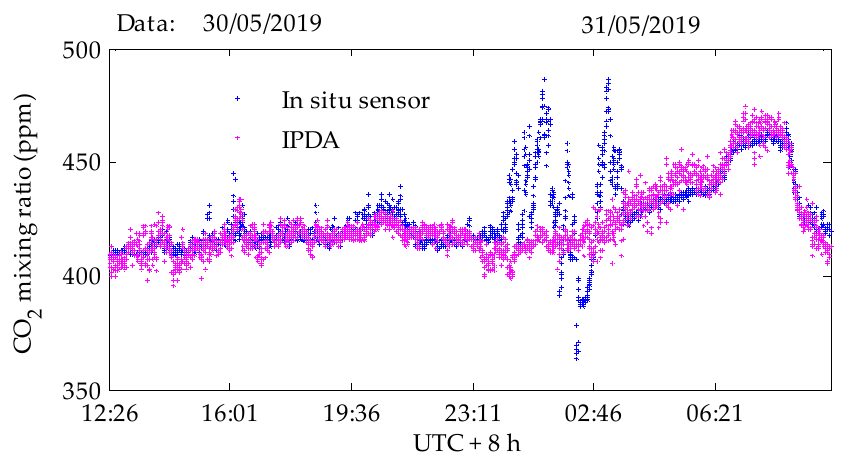
Figure 17. Simultaneous measurements of the diurnal variations of atmospheric CO 2 with the improved IPDA lidar system and an in situ sensor. Black boxes indicate rainy weather. The integral path length is 580 m.